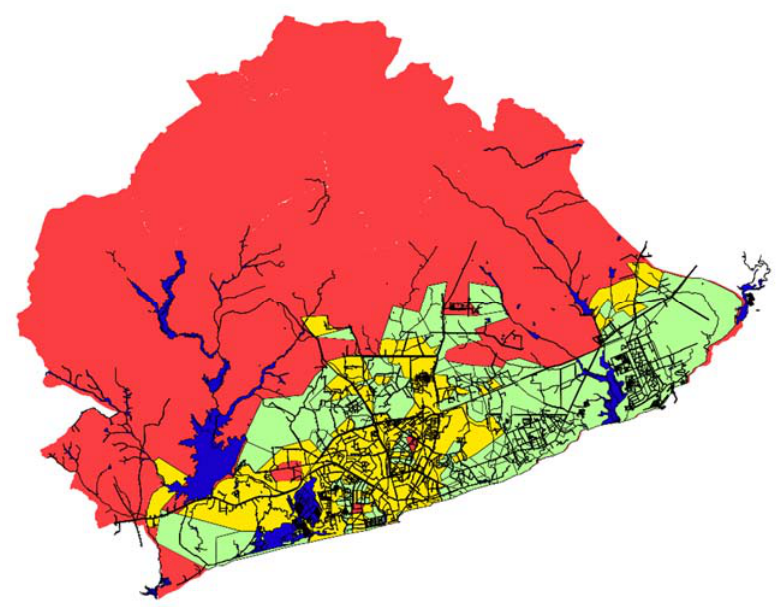
Figure 3. Zones in GAMA supplied by the pipe and rationing scheme as of August 2015 (areas with no access to pipe supply (red), areas with continuous pipe supply (blue), areas with rationed supply (yellow), water bodies (turquoise), and the pipe network (dark lines)). Source of data: Ghana Water